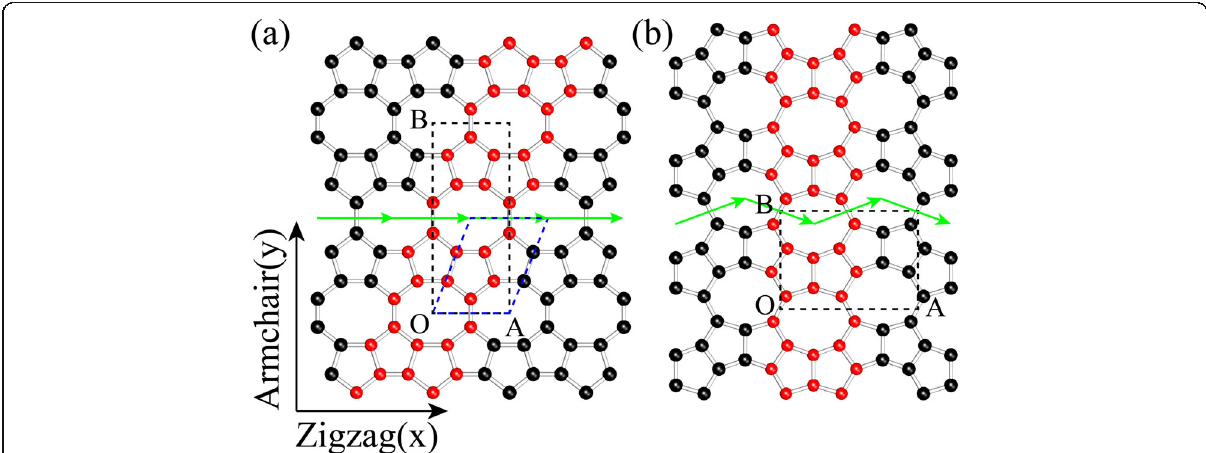
Fig. 1 The schematic models of a OPG-L and b OPG-Z. The black dashed frames are the orthogonal unit cells of OPG-L and OPG-Z, where OA and OB are lattice vectors. The primitive cell of OPG-L is shown in blue dashed frame while the primitive cell of OPG-Z is the same as the crystal